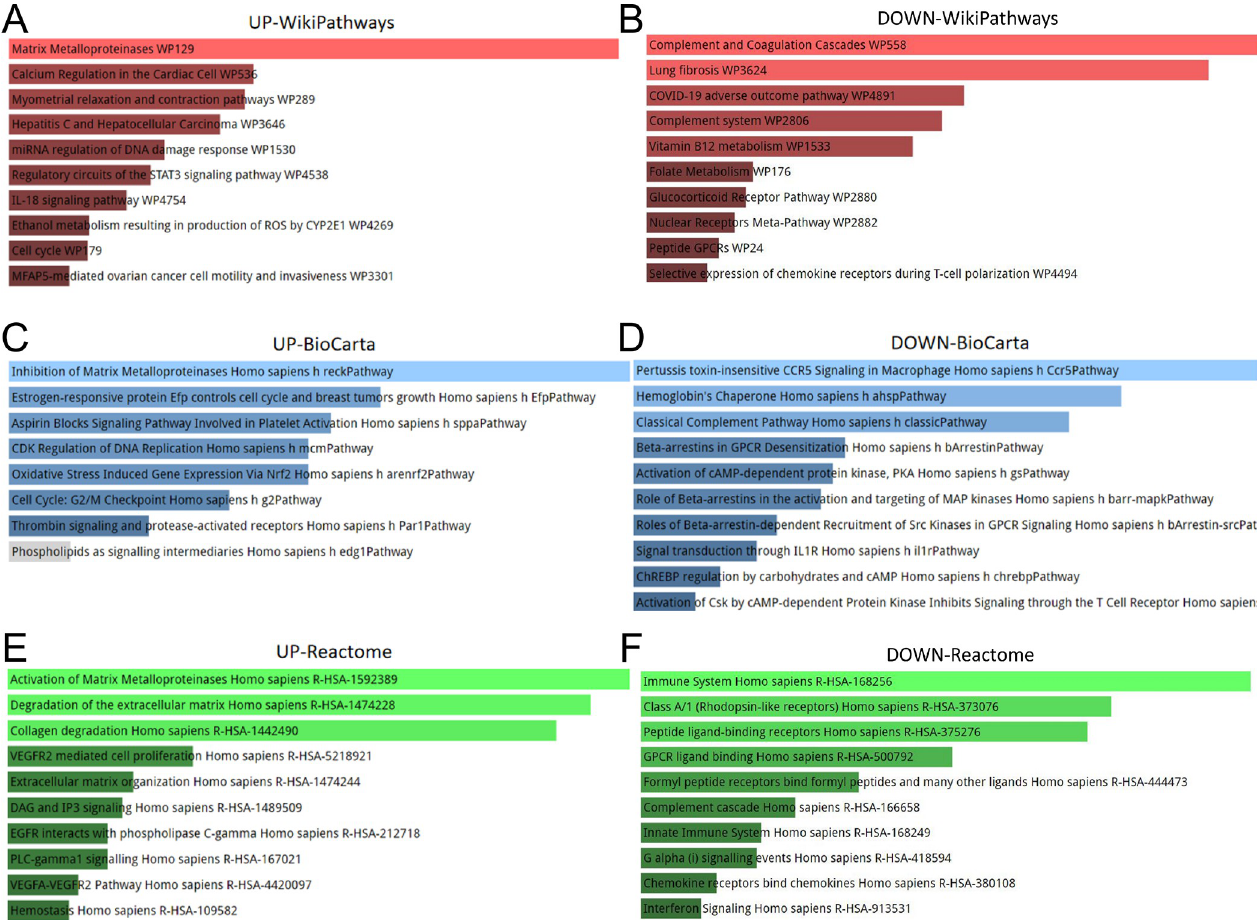
Fig 4. Pathway analysis was performed by WikiPathways, BioCarta and Reactome for result identification: (A, B) WikiPathways, (C, D) BioCarta and (E, F) Reactome.